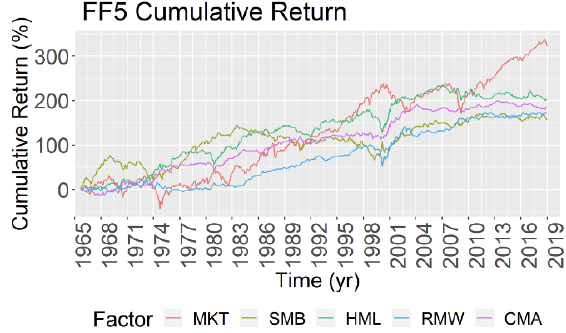
Figure 3. Cumulative returns of the five factors (1965–2018).